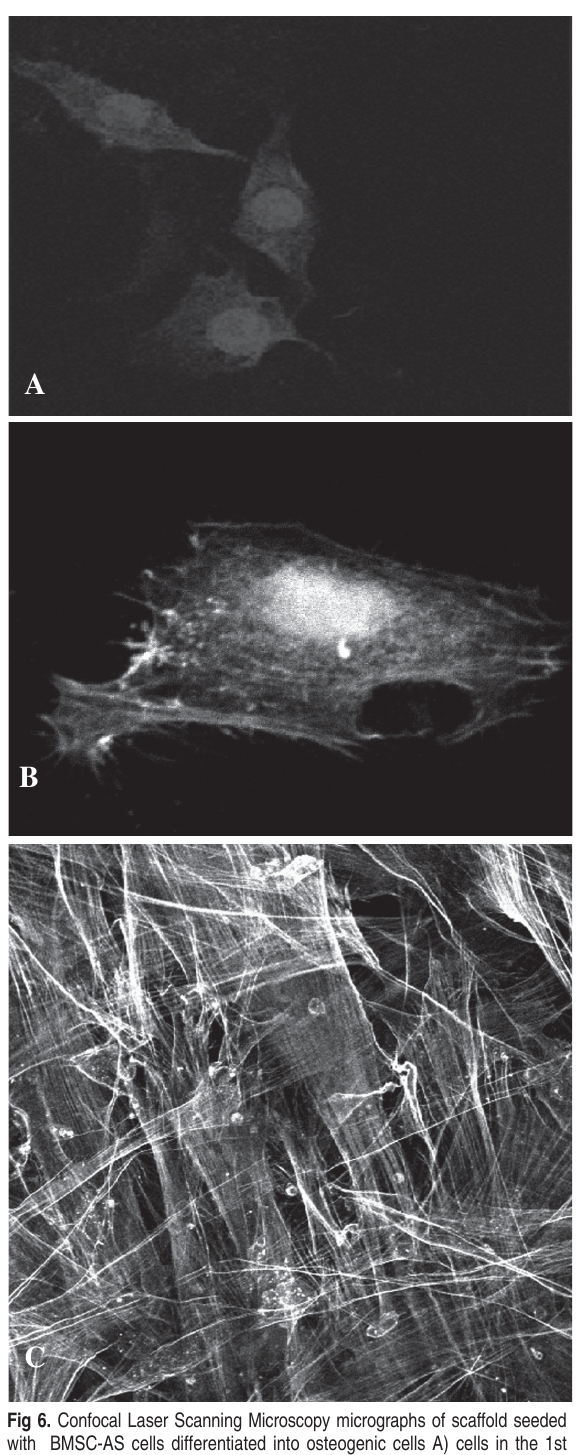
Fig 6. Confocal Laser Scanning Microscopy micrographs of scaffold seeded with BMSC-AS cells differentiated into osteogenic cells A) cells in the 1st week showed short cellular extension B) stress fibers extending from the cells . C) many cells elongated and formed long processes extending away from the cell body(X